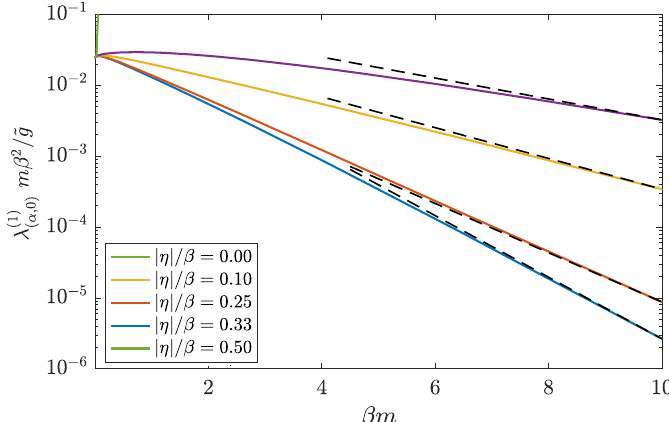
Figure 7 . Exponential decay of the (cid:12)rst Lyapunov exponent for various contours . Dashed lines correspond to the analytical expression Ce (cid:0) ( (cid:12) +2 j (cid:17) j ) m , where C is (cid:12)xed so that the dashed line passes through the last point available (cid:12)m = 10. For brevity, we de(cid:12)ned ~ g = g 4 ( N 2 +5)